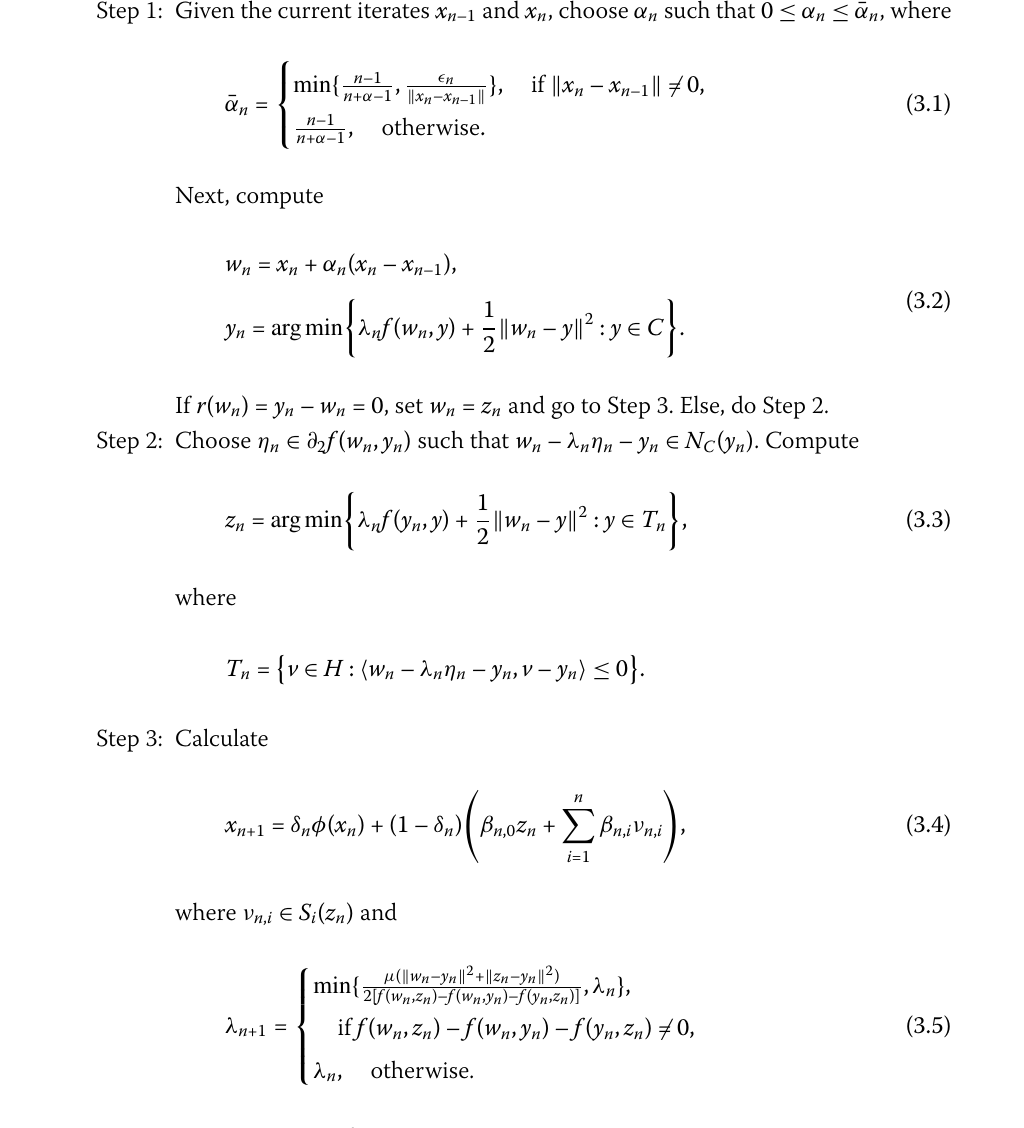
Algorithm 3.1: Self-adaptive inertial subgradient extragradient